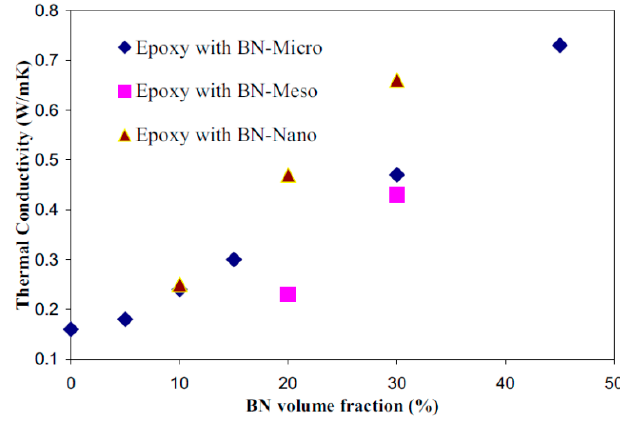
Figure 39. The thermal conductivities of the epoxy composites filled with BN-Micro, BN-Meso and BN-Nano (© 2016 IEEE. Reprinted, with permission, from [173]).